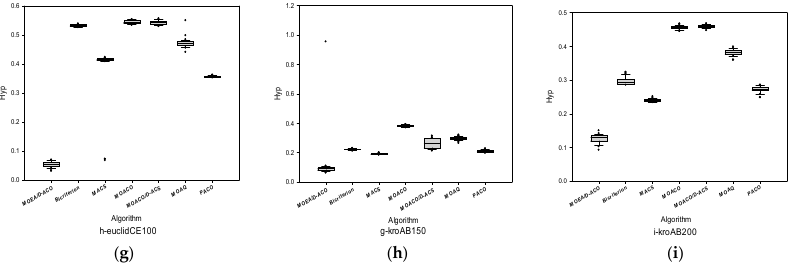
Figure 4. The box plots based on the H-indicator on some instances shown as in ( a ) a-kroAB100, ( b ) i-kroAC100, ( c ) c-kroAD100, ( d ) d-kroCD100, ( a ) e-kroCE100, ( f ) f-euclidAB100, ( g ) euclidCE100, ( h ) h-kroAB150 and ( i ) i-kroAB200.